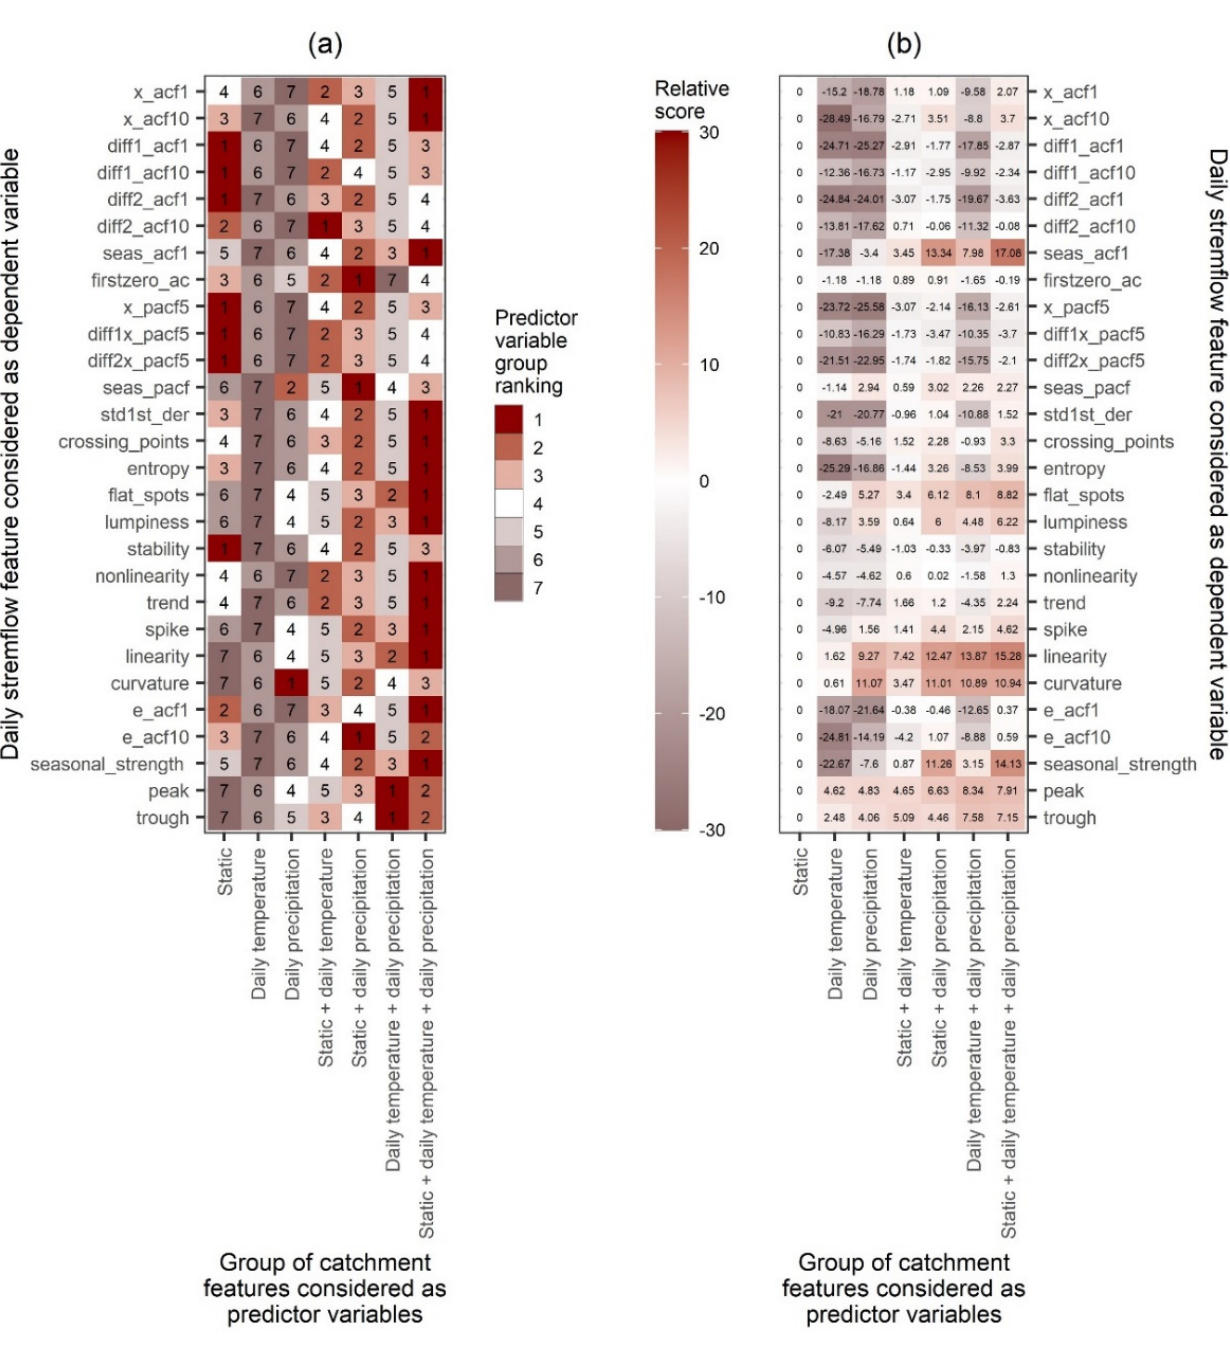
Figure 4. Performance comparisons between seven prediction methods that use random forest with different catchment feature groups as predictor variables. These comparisons were made over the 511 investigated catchments under a 10-fold cross-validation setting. They take the form of ( a ) rankings of the predictor variable groups from the best (1 st ) to the worst (7 th ) performing in terms of root mean square error, and ( b ) relative performance differences (%) with respect to using only the static features as predictor variables. The displayed feature abbreviations are explained in Section 2.2.